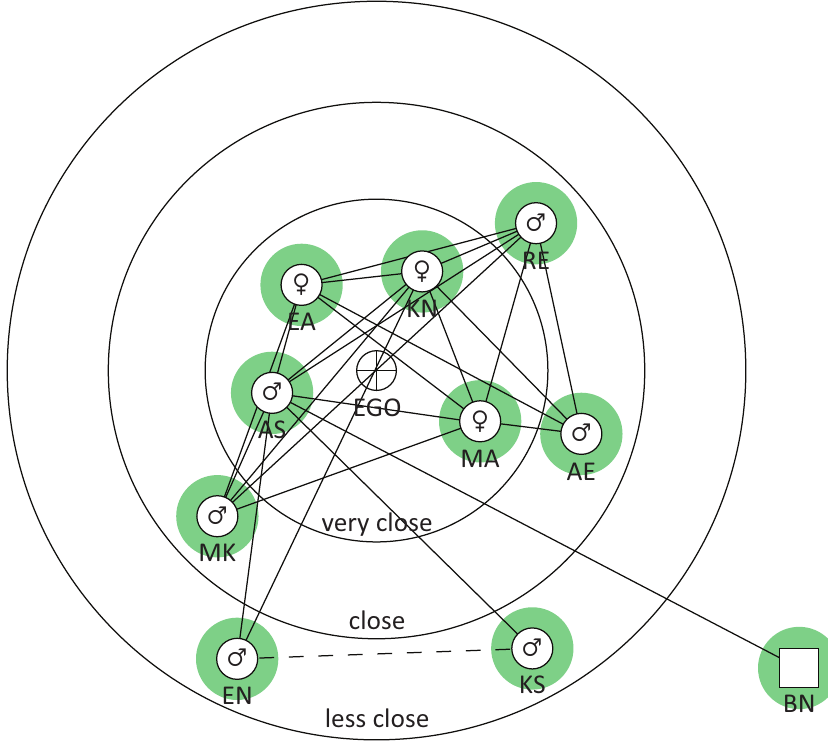
Figure 1. Anonymised network map of Mrs Lindemann (see Section 4.2). Own illustration with